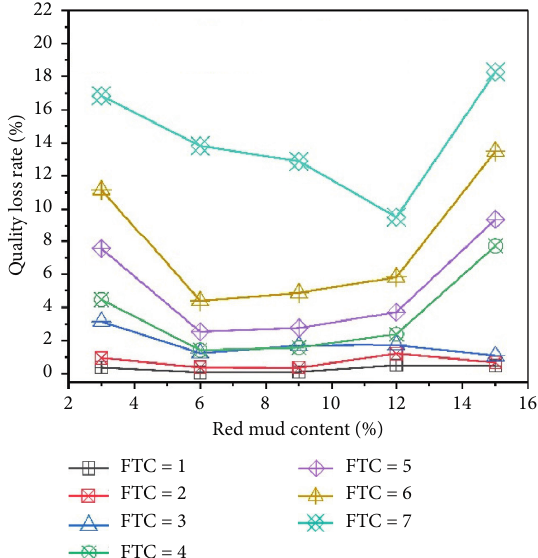
Figure 8: The relationship between the mass loss rate and red mud content.